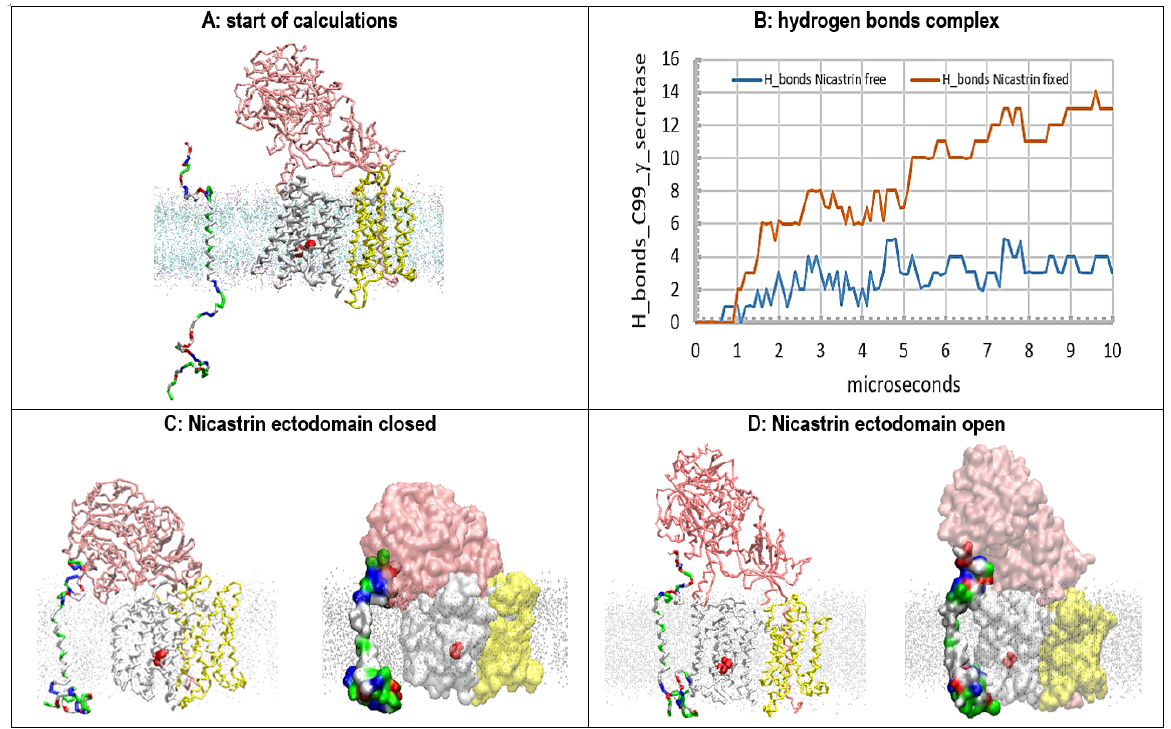
Figure 6. ( A–D ) Multiscale MD studies of the docking of the free C99- β CTF-APP substrate to γ -secretase: no substrate bound in the active site. The γ -secretase complex shows nicastrin (pink), presenilin 1 (white), and Aph1 and Pen2 (yellow). Red beads depict the active sites Asp 257 and Asp 385. The silver dots represent the cholesterol–lipid bilayer. The free C99- β CTF-APP substrate is colored as hydrophobic (white), negative (red), positive (blue), and polar non-charged (green). The backbone models are used to show protein conformers, while the partially transparent Connolly surfaces are used to show protein–protein contacts [43] . ( A ) Residue-based coarse-grained MD calculations started with the fully extended C99- β -CTF-APP structure that was positioned between 5 and 20 Å away from the γ -secretase complex with its nicastrin ectodomain open. ( B ) The buildup of protein–protein interactions is described quantitatively by counting H bonds that form in calculated molecular time (10 µs). The initial lag represents the diffusion time and the conformational changes that take place after the first contact. The subsequent steps in the graph represent confor-